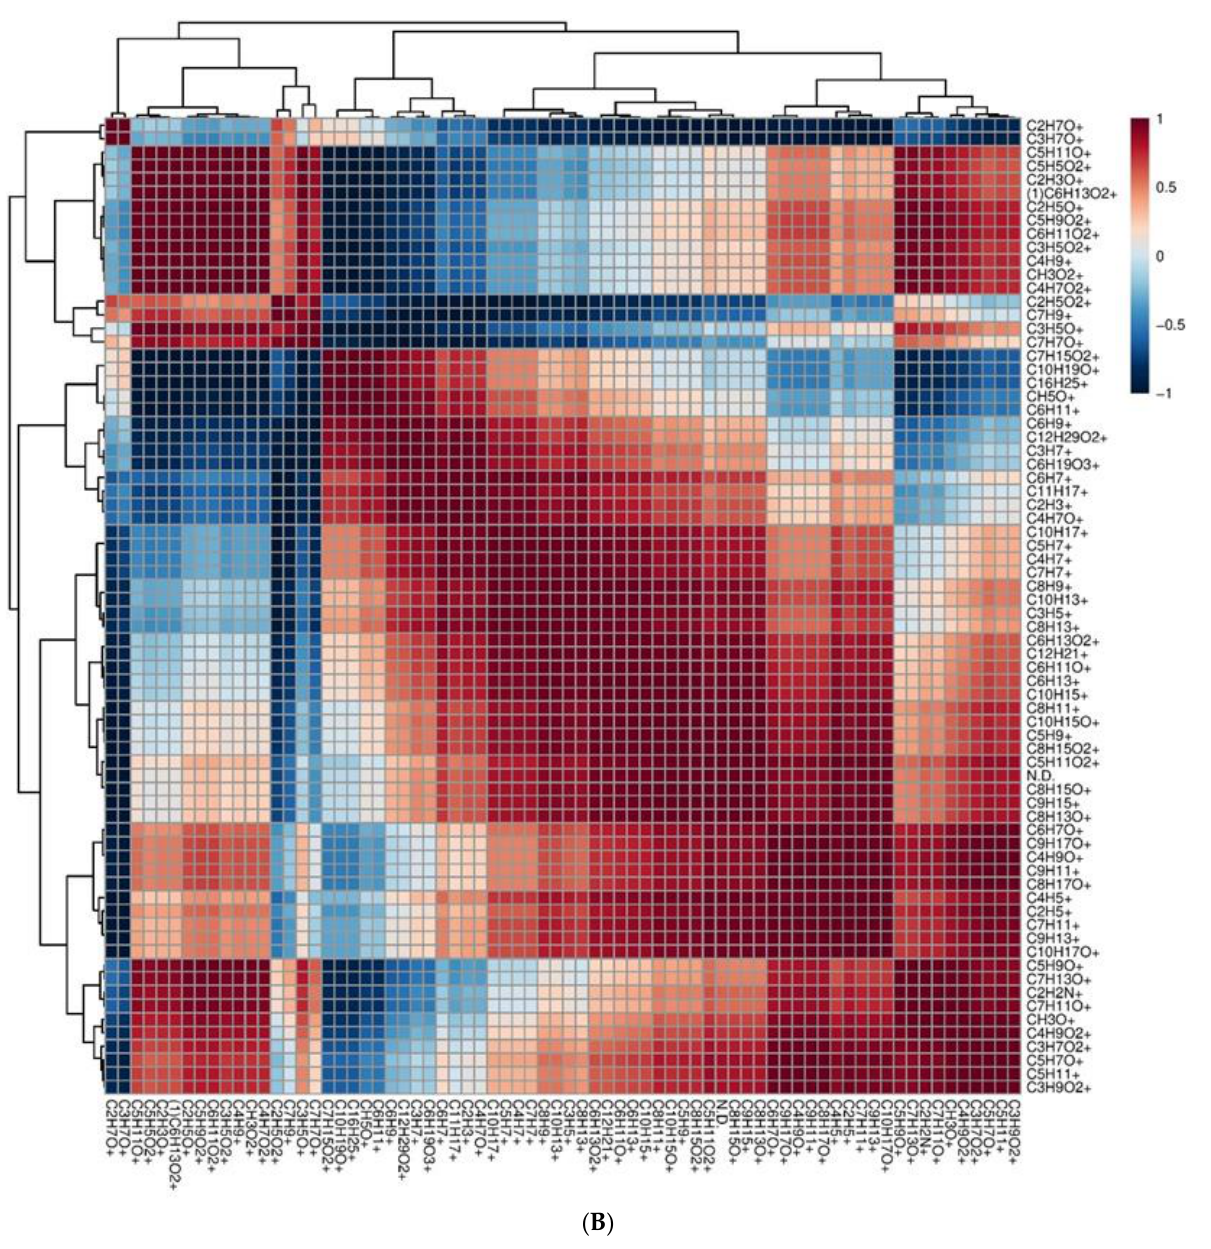
Figure 5. ( A ) Correlation matrix based on Pearson correlation coefficient among different com- pounds deriving from pollen with dendrogram. ( B ) Correlation matrix based on Pearson correlation coefficient among different compounds deriving from pollen extracts with dendrogram.